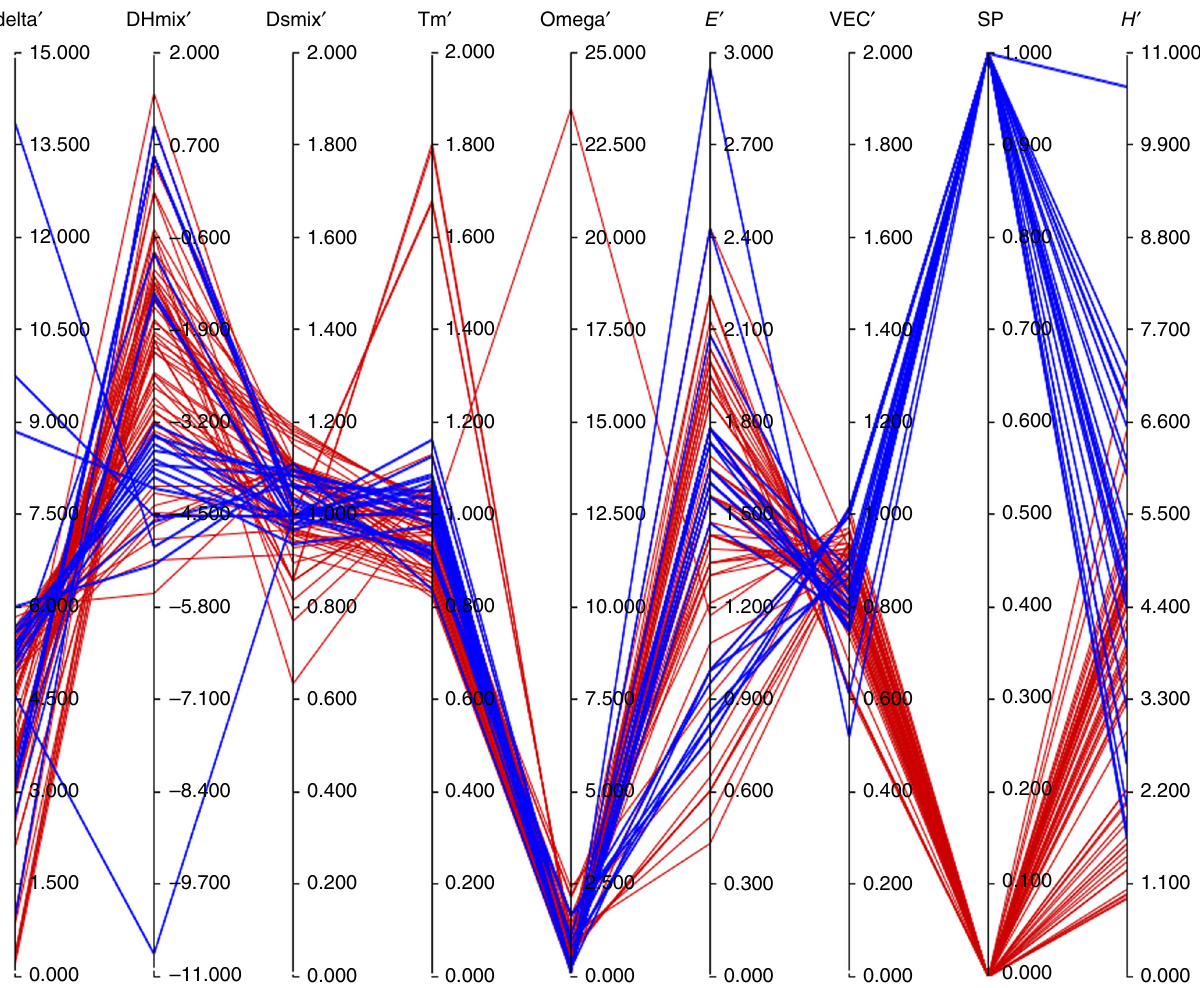
Fig. 1 Parallel coordinate plot. A parallel coordinate plot displaying both normalized metrics and property data for a set of high-entropy (HE) alloys. The phase behavior of the alloys is summarized in the variable single phase (SP) (unnormalized), with SP = 1 indicating alloys comprising a single, solid – solution (either fcc or bcc) and SP = 0 otherwise. Solid – solution alloys are shown in blue, with the remaining alloys having intermediate phases, etc., shown in